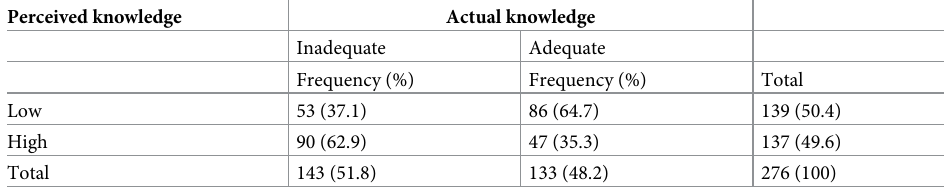
The results for the LF knowledge differentials were: LF knowledge underestimators-86; Accurate LF knowledge estimators-100 and LF knowledge overestimators-90. However, to put these results into proper perspectives and validate it, HCWs designations/occupational catego- ries were used to stratify the reclassified self-perceived LF knowledge scores (High and Low) and actual LF knowledge scores (Inadequate and Adequate) by cross-tabulation (Table 5). The resultant Table showed three types of LF knowledge estimators: accurate estimators, under-estimators and over-estimators with all the nine different HCWs’ designations having members in each of the three types of LF knowledge estimations. Accurate LF knowledge esti- mators comprised 36.2% (100/276) of those who were trained on LF and were characterized by those who believed (predicted and in reality) they were below average (53%; 53/100) or above average (47%; 47/100). The top three HCWs in this category were: medical doctors- 22%, 22/100; nurses-18%, 18/100 and midwives-16%, 16/100. The over-estimators constituted 32.6% (90/276) of those who were trained on LF and were those whose perceived themselves Table 5. Differences in the levels of LF knowledge among healthcare workers who were aware of the LF outbreak (N =